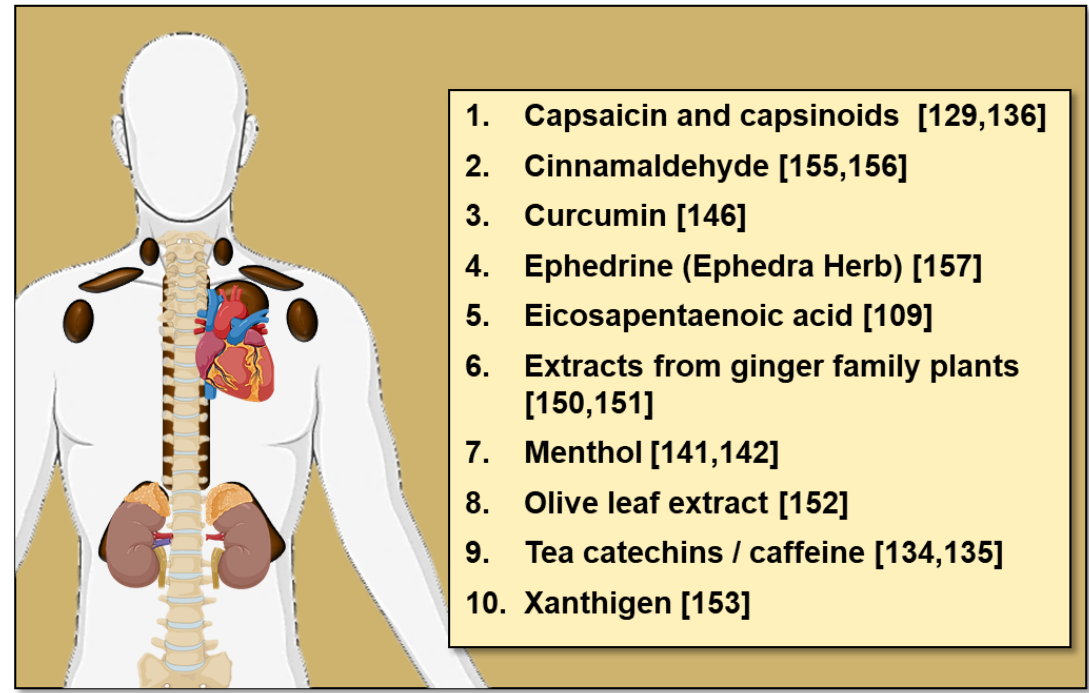
Figure 3. Dietary compounds with thermogenic potential in